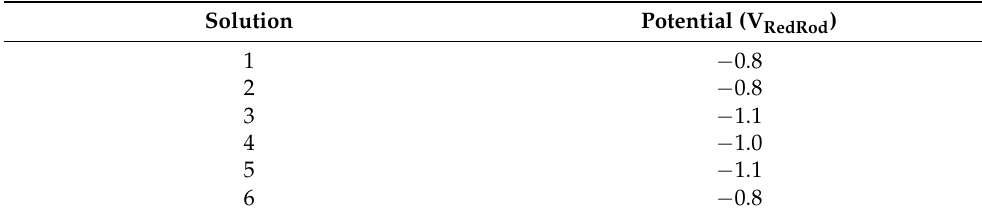
Table 3. Potential at which the surface became dark.